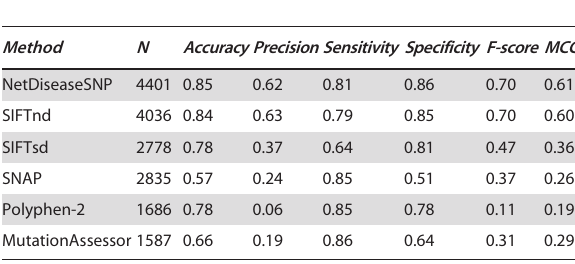
Table 4. Benchmark of NetDiseaseSNP: Cancer drivers and